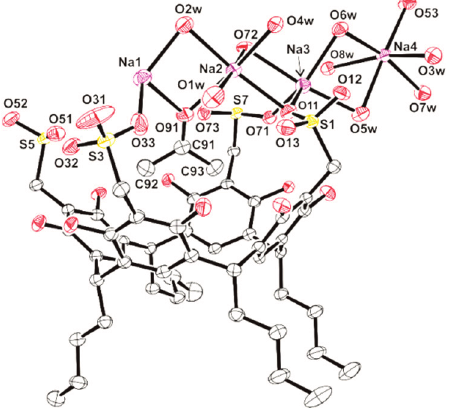
Figure 2. Asymmetric unit of the crystal structure for 2a (thermal ellipsoids at the 50% probability level). Hydrogen atoms and molecules of acetone are omitted for clarity. Symmetry transformations: (a) x , y + 1, z